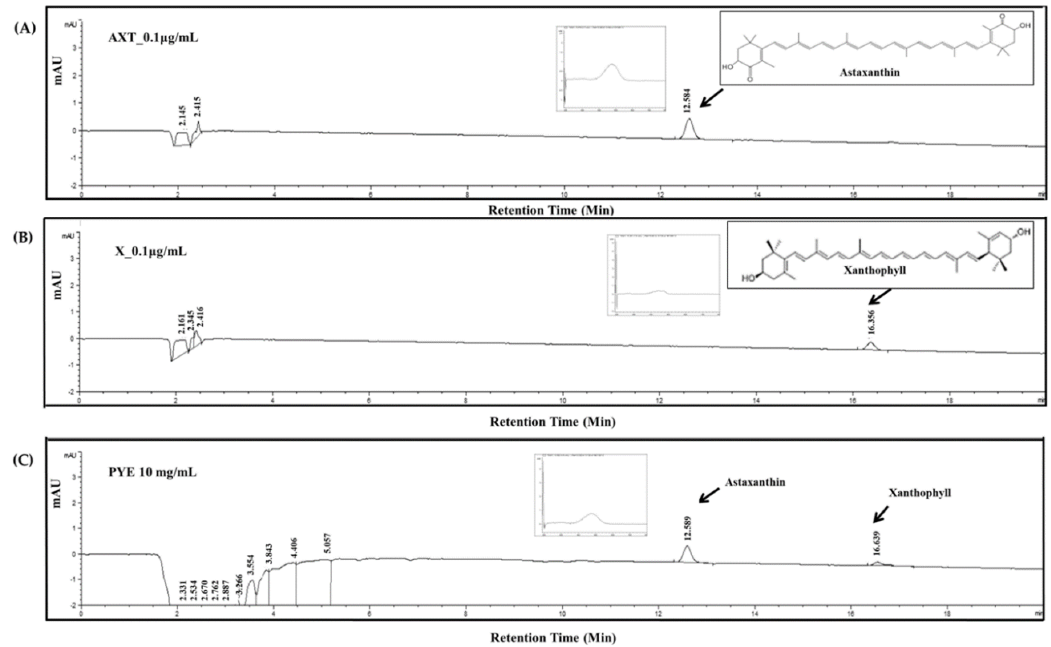
Figure 6. The representative chromatograms of ( A ) astaxanthin (AXT) standard at 0.1 μg/mL, ( B ) xanthophyll (X) standard at 0.1 μg/mL, and ( C ) Pyropia yezoensis extract (PYE) at 10 mg/mL detected by high-performance liquid chromatography (HPLC) with a diode-array detector (DAD) at 470 nm. The flow rate was 1.0 mL/min, and the sample injection volume was 50 μL.